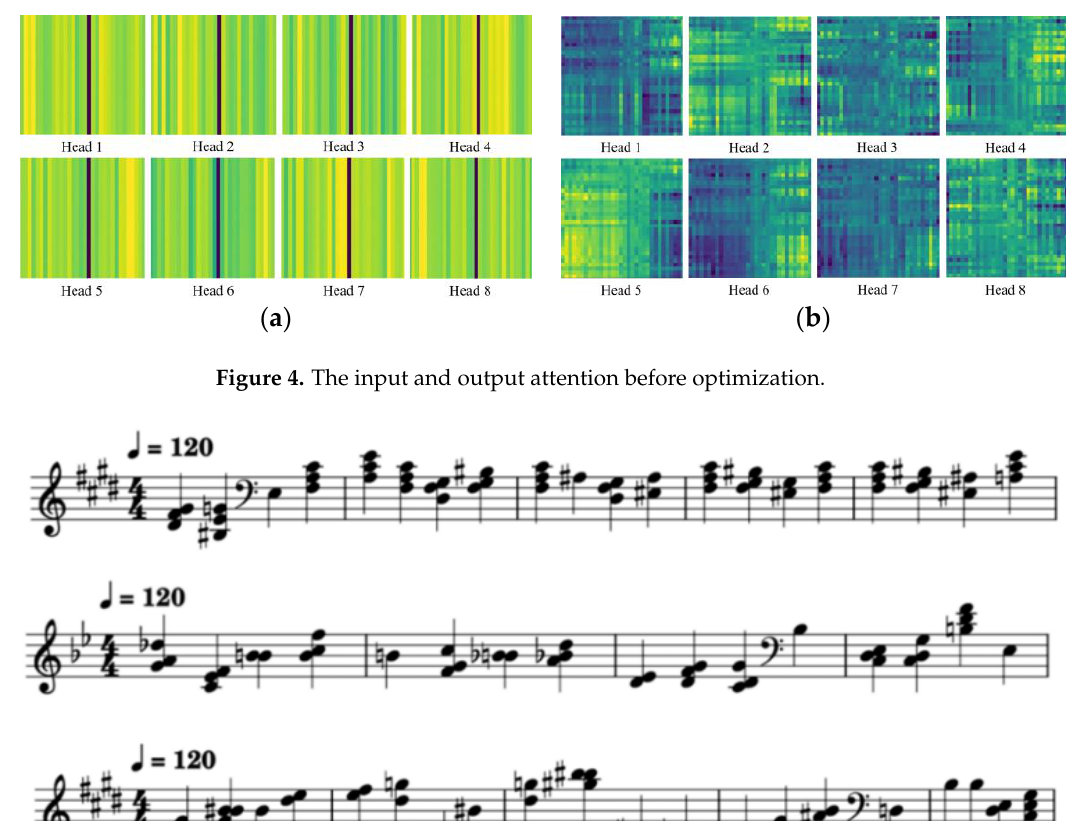
Figure 4. The input and output attention before optimization.